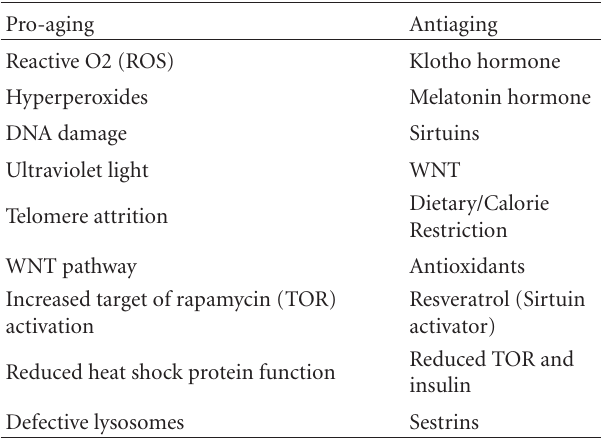
Table 1: Pro- and antiaging